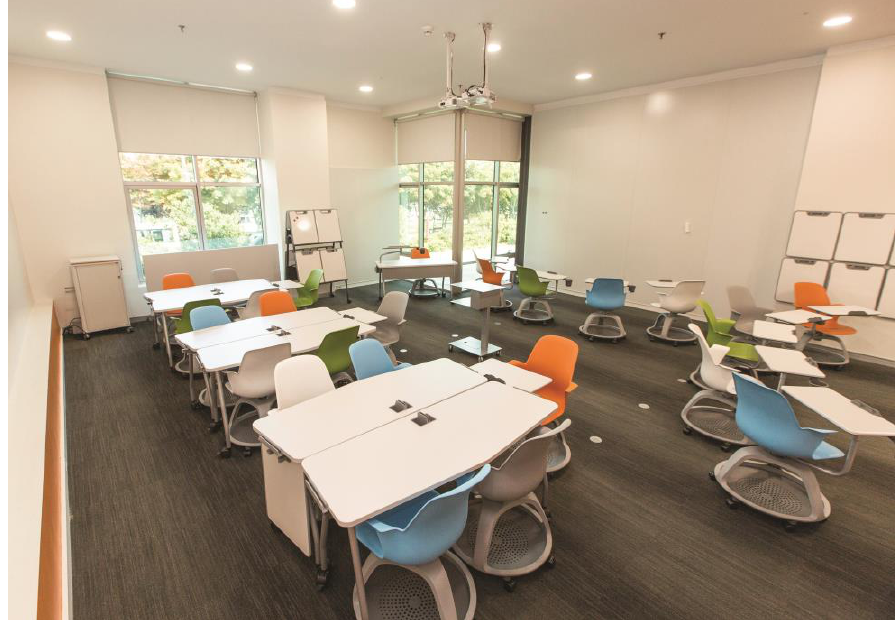
Figure 3. Active learning center (ALC) configuration supporting group studies.